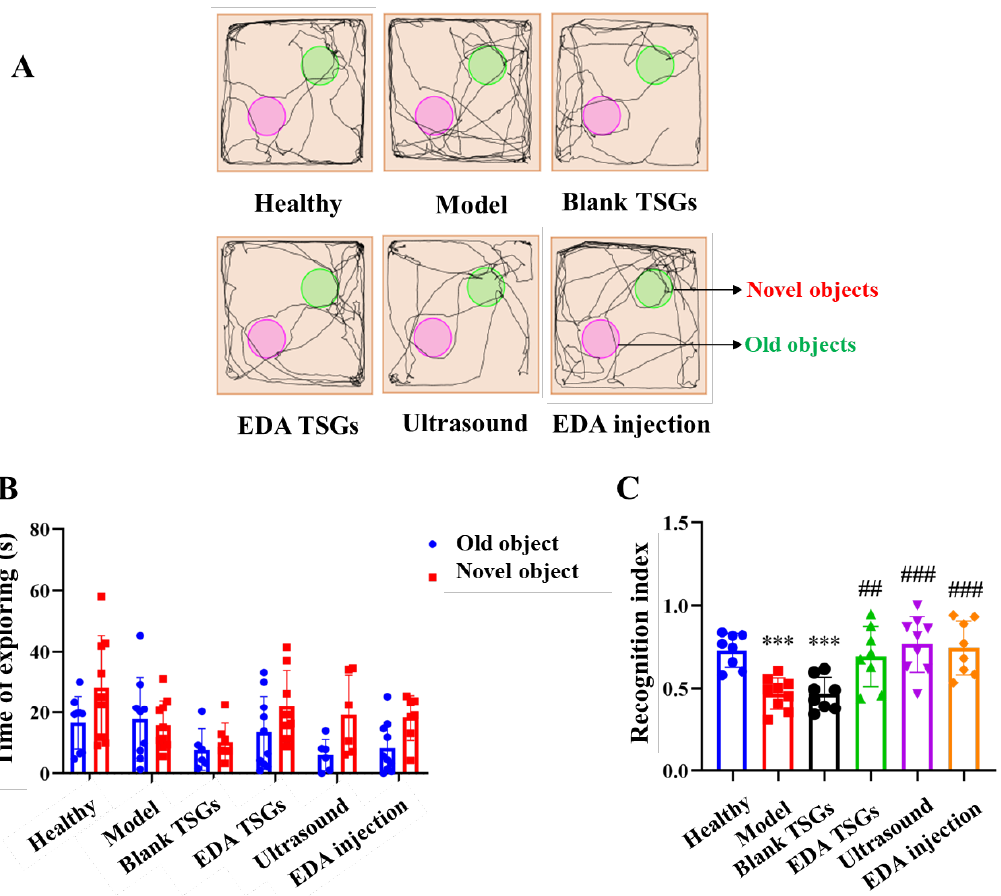
Figure 8. Comparison of learning and memory of mice in each group by the novel object recognition test. The track map ( A ); Statistical data analysis of the time of exploring ( B ) and recognition index ( C ). Data are represented as mean ± SD ( n = 10). *: means significant difference, vs. the healthy group, *** p < 0.001; # : means significant difference, vs. the model group, ## p < 0.01, ### p < 0.001.